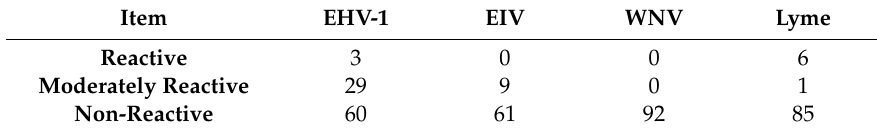
Table 1. Summary of Serologic Assay Results . The number of animals with serum antibodies that were reactive, moderately reactive, or non-reactive against each of the pathogens investigated. Item EHV-1 EIV WNV Lyme Reactive 3 0 0 6 Moderately Reactive 29 9 0 1 Non-Reactive